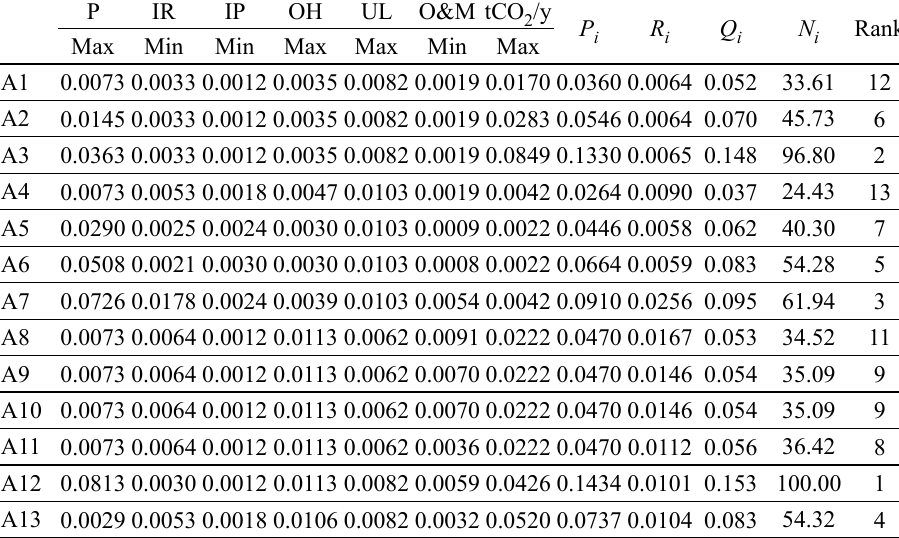
Table 10. Ranking results of